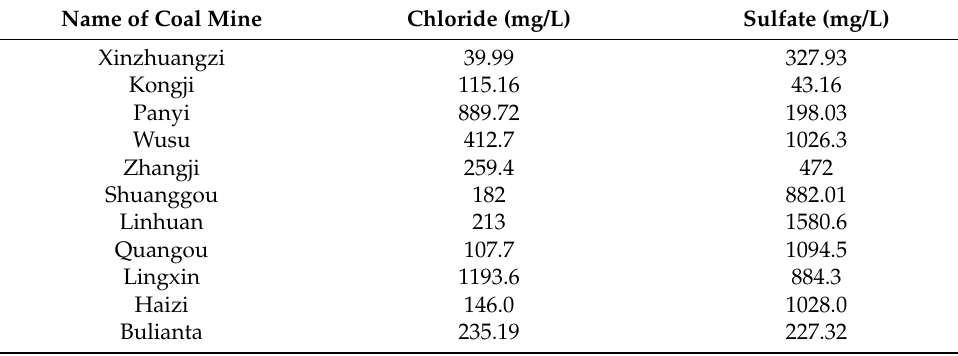
Table 1. Part of mine salt ion content